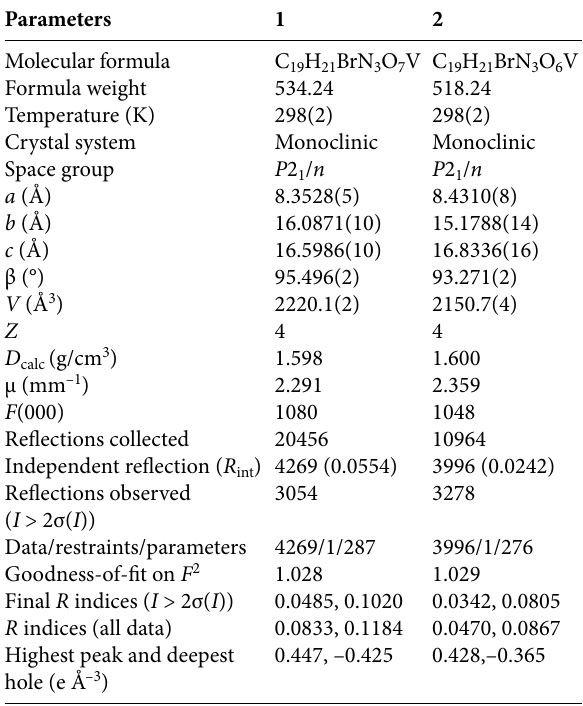
Table 1. Crystal data and structure refinement for the complexes